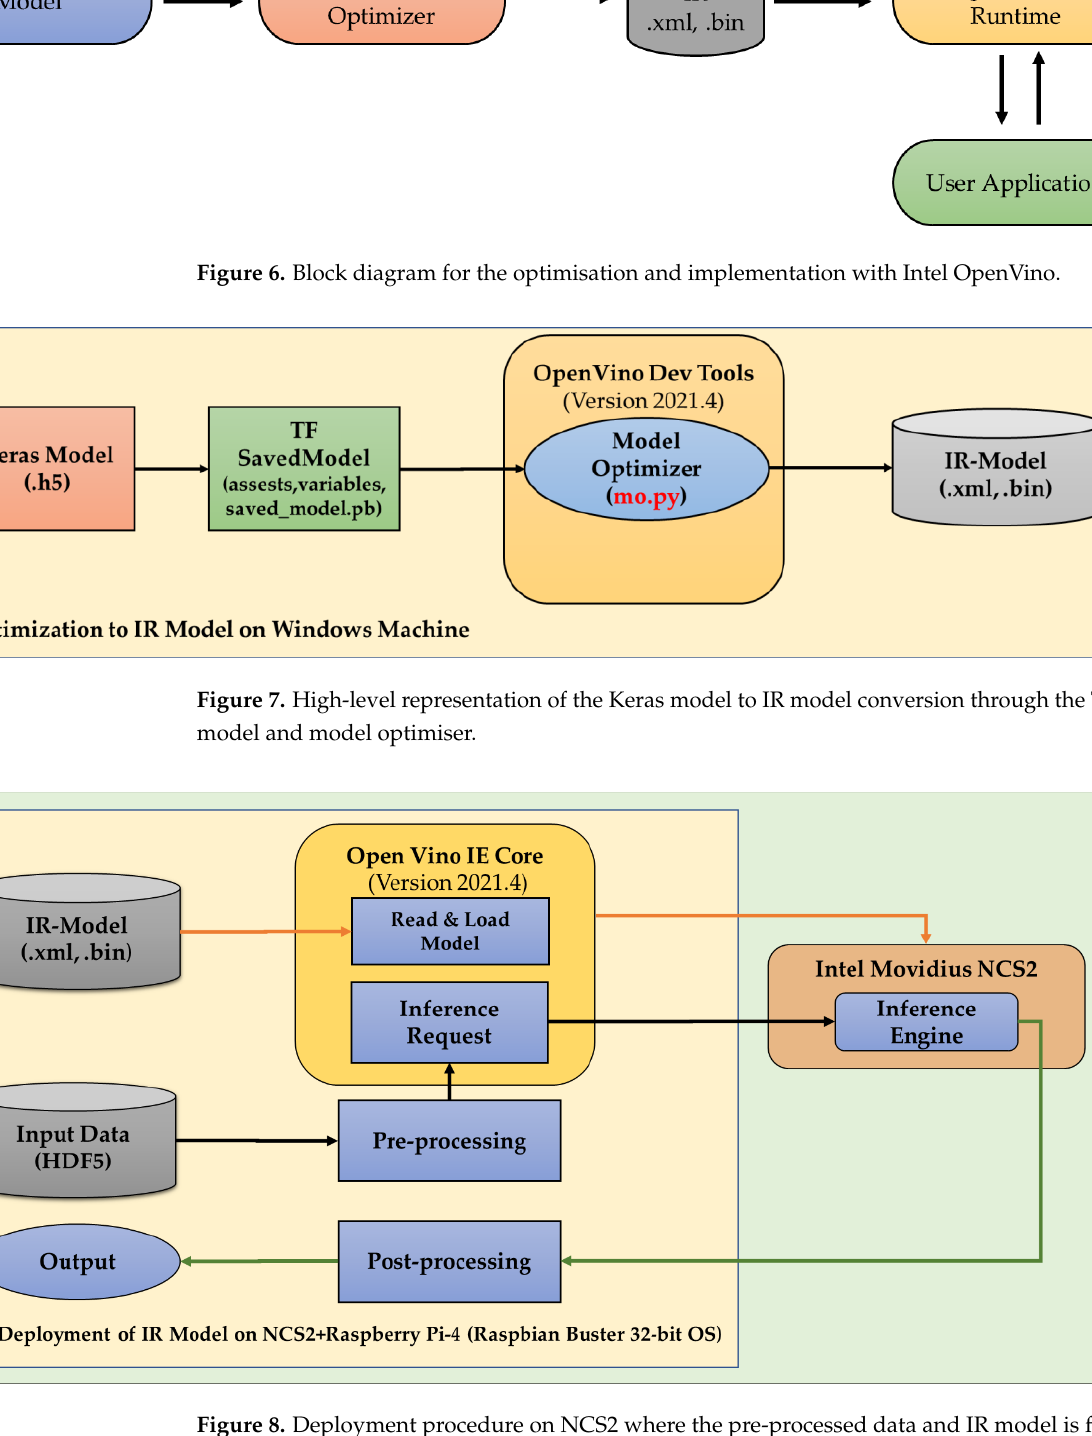
Figure 8. Deployment procedure on NCS2 where the pre-processed data and IR model is fed to the inference engine and the results are acquired.